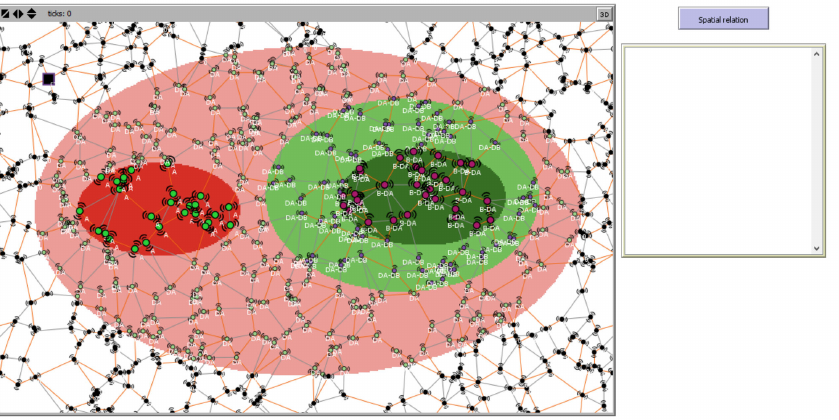
Figure 7. Excerpt of Netlogo environment showing A’s boundary covering B within SN extent. The output of decentralized spatial reasoning for boundaries detection changes the shape of nodes detecting phenomena boundaries, and the I 5 × 5 M elements are aligned with the sensors’ spatial state; updated I 5 × 5 M is inserted in the output area followed by a spatial description of the scene computed from I 5 × 5 M structure and elements value; this is shown in Figure 8.